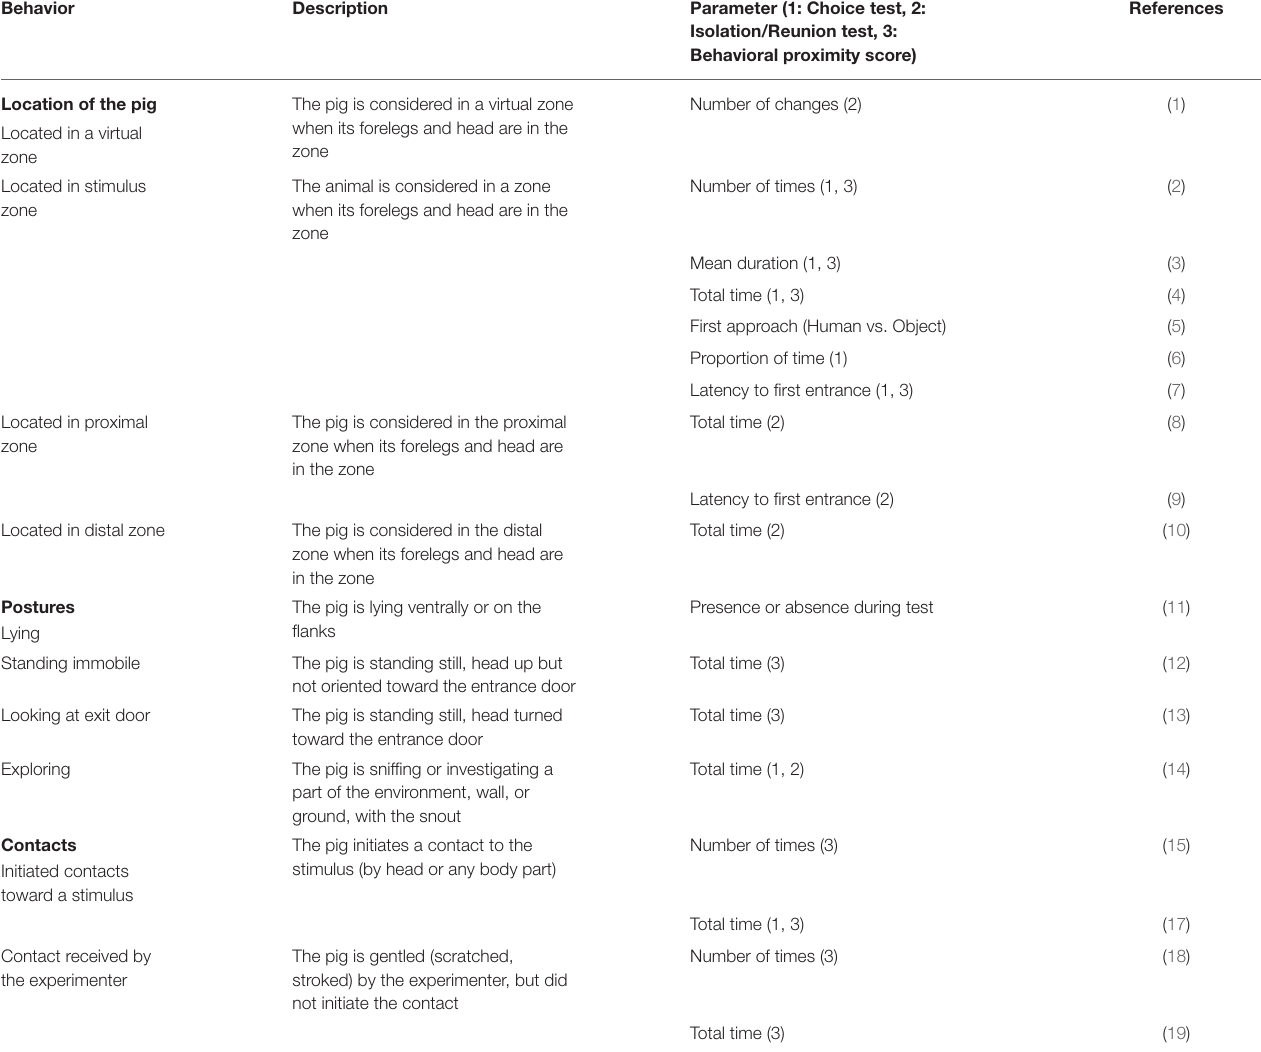
TABLE 1 | Ethogram used for the Choice test (1), Isolation/Reunion test (2), and behavioral proximity scores (3).